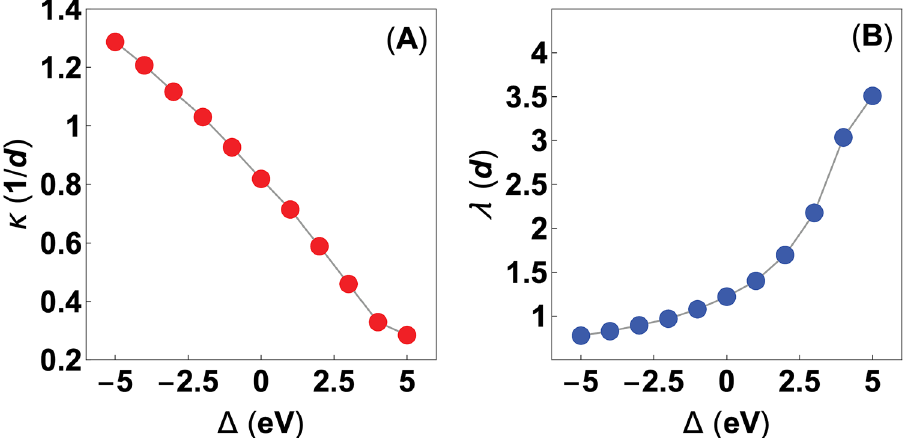
Figure 4. ( A ) The characteristic decay rate ( κ ) and ( B ) corresponding decay length ( (cid:31) ) of the metal- induced gap states in the CsCl insulator structure, for the selected values of the onsite energy deviation 5 eV, 5eV ( (cid:31) ). Note, that the κ and (cid:31) parameters are presented in the units that base on the primitive unit ∈ [− ] cell size ( d ) of the CsCl insulator